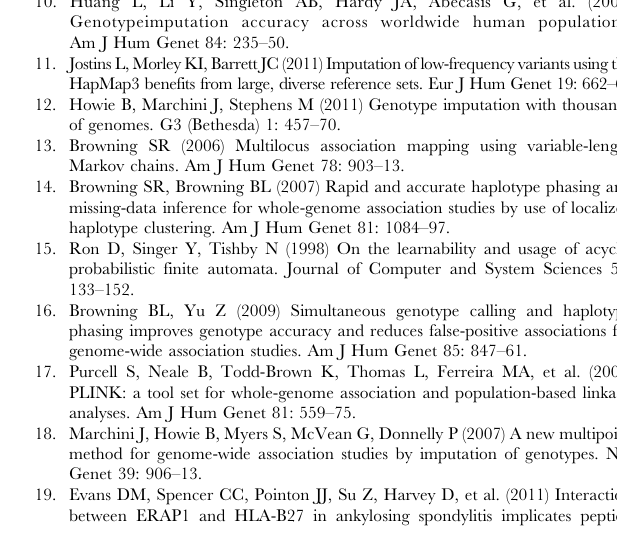
Table S2 Countries and ethnicities in HLARES. Country and ethnicity of samples in the HLARES_EU and HLARES_ALL datasets. Table S3 HLA-DPB1 and DRB3-5. HLARES_EU cross validation for additional loci and structural variation (second experiment, medium heterogeneity): 2/3 of the HLARES_EU dataset are used as reference to impute the remaining 1/3. No call threshold is employed. Accuracy (PPV) for HLA-DPB1 measured at 4-digit resolution, at 2-digit resolution (including one pseudo- allele for absence) for DRB orthologs.